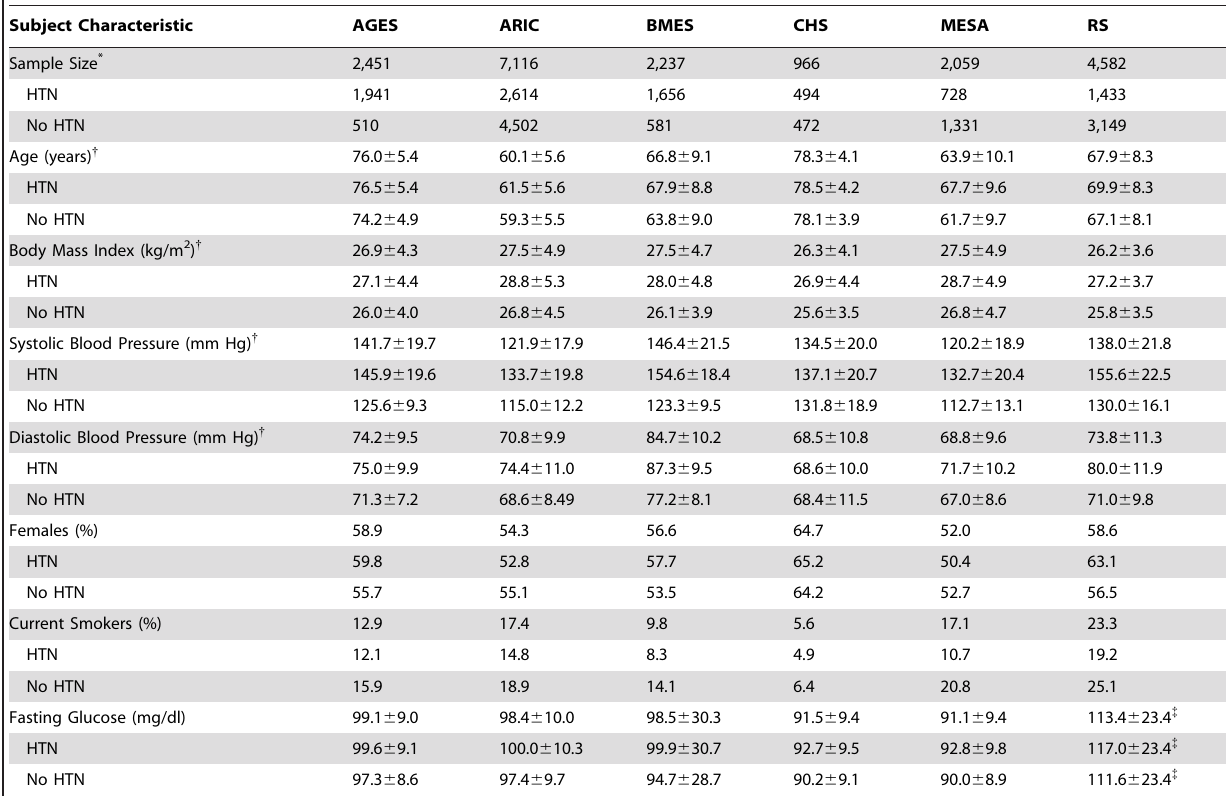
Table 1. Subject characteristics by study